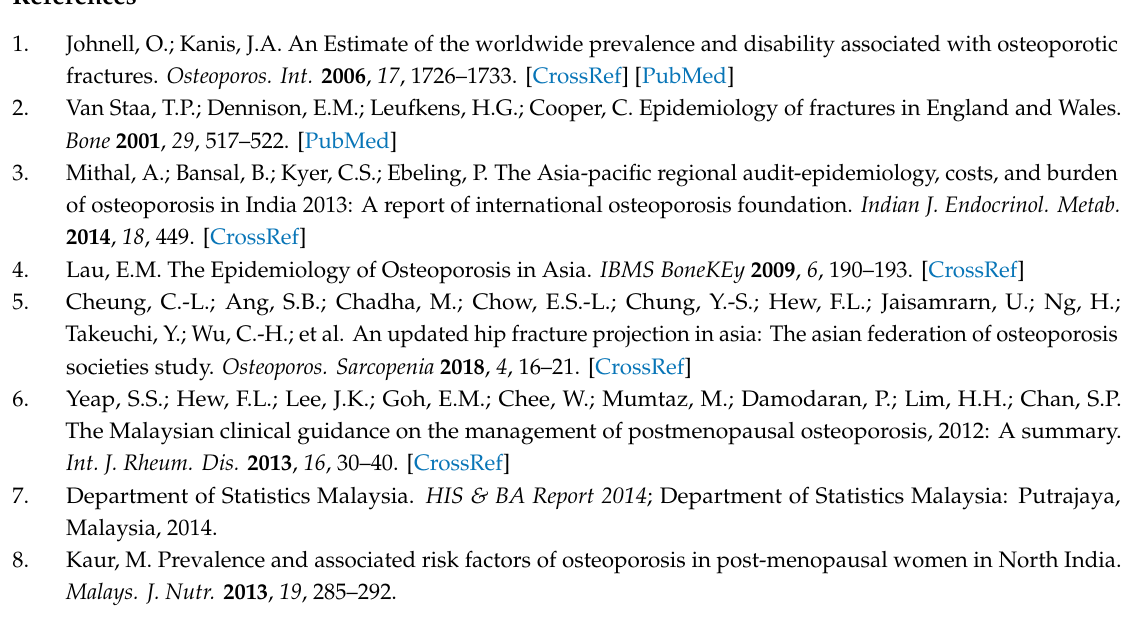
Table S1: The distribution of responses to osteoporosis knowledge questions of subjects, Table S2: Response to the OHBS among the